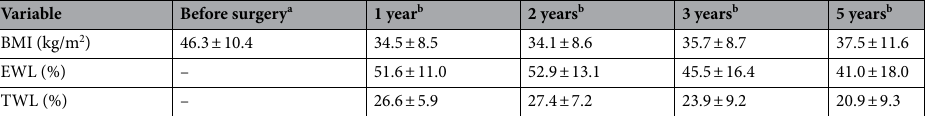
Table 3. Trend of change in BMI, %EWL and %TWL during 5 years after conversional surgery (using parametric repeated measure ANOVA; P value < 0.001 for BMI, P value-0.008 for TWL and P value = 0.032 for EWL). BMI body mass index, EWL excess weight loss, TWL total weight loss. Values are mean ± standard deviation. a Just before conversional surgery. b After surgery.